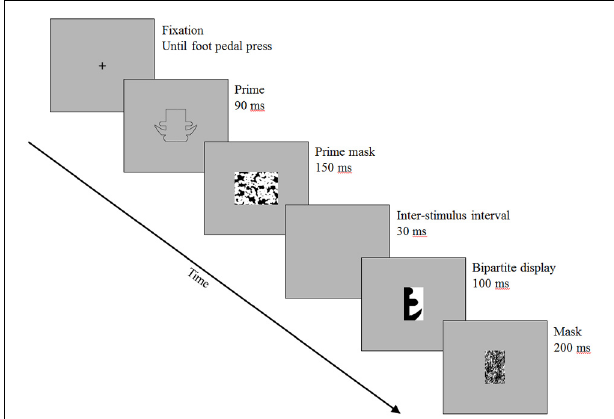
FIGURE 3 | Trial structure. Shown here is an upright trial (an anchor is in black on the left side of the bipartite display) in the part-rearranged condition. Stimuli are enlarged with respect to the frame size for illustrative